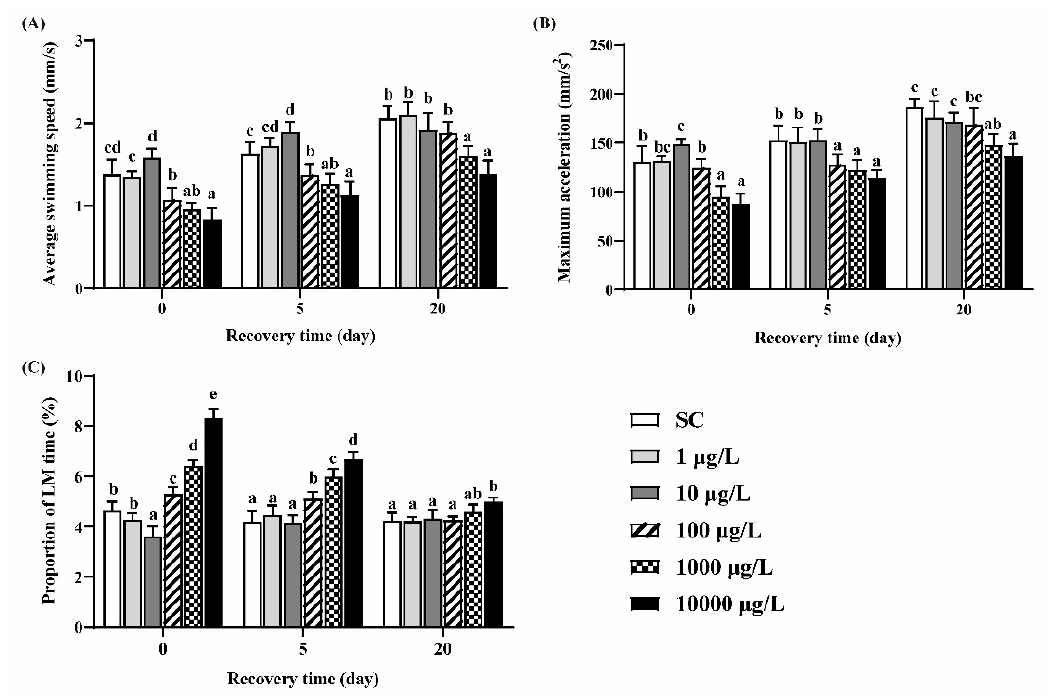
Figure 3. The ASS ( A ), MMA ( B ) and PLT ( C ) of zebrafish larvae under light conditions. One-way ANOVA followed by Tukey’s post hoc tests was used to determine statistical differences. Different letters indicate statistically significant differences between different treatment groups at the same time ( p < 0.05).